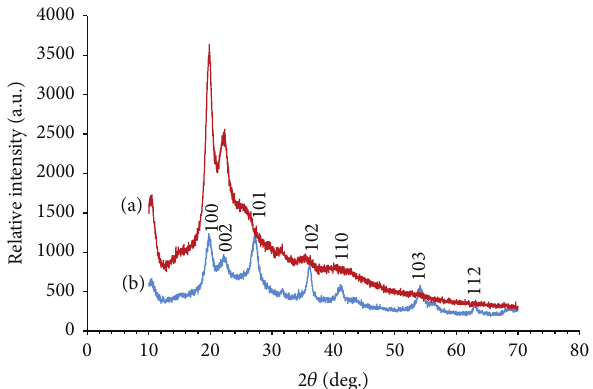
Figure2:X-raydiffractionpatternsofc-MWCNTs(a)andAuNP/c- MWCNTs